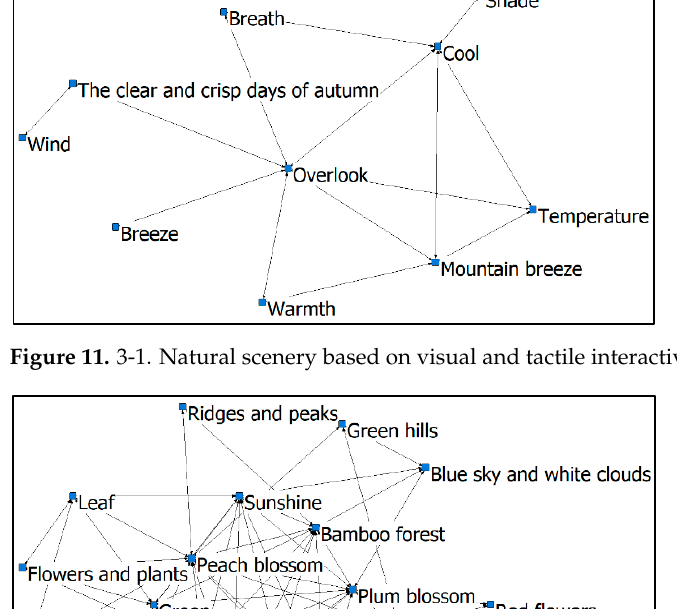
12 of 20 Figure 9. 1-3. Visual and olfactory interactive experience during outdoor activities. Cluster 1-3 is a collection of outdoor activities carried out by tourists in Baiyun Moun- tain Urban Forest Park. The clustering image shows that ‘Picnic’ is closely connected with green space, lawn, and air, which indicates that tourists pay more attention to the service level of infrastructure of the park when they have picnics. The frequent occurrence of ‘Flower fragrance’, ‘Oxygen’, and ‘Fresh’ bears out that visitors’ olfactory interactive per- ception activities are significant and specific. Clusters 1-1,1-2 and 1-3 show that tourists pay critical attention to air perception when using the park.